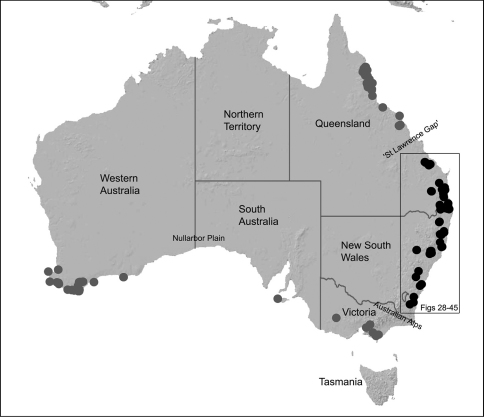
Map showing the known distribution of Archaeidae in Australia, with mid-eastern Australian localities highlighted in black. Note the absence of Archaeidae in central-eastern Queensland, the Australian Alps and Tasmania.